Question: Provide a one-line summary of what is displayed.
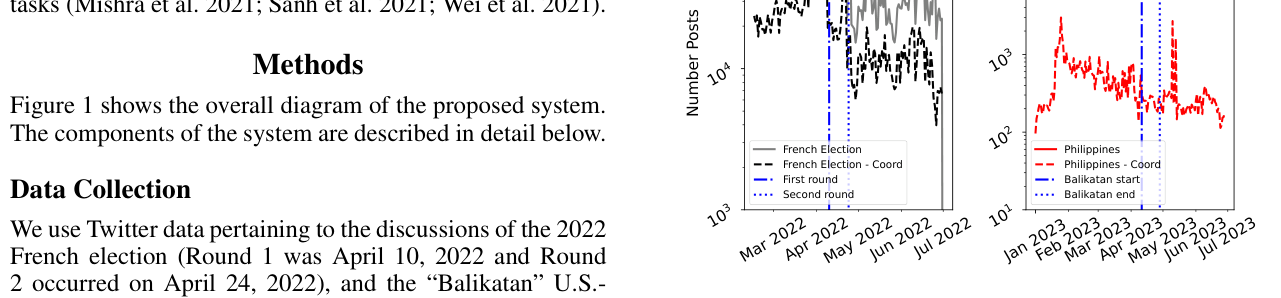
Answer: Number of posts over time from coordinated and non-coordinated accounts. (a) 2022 French election, with Round 1 and Round 2 elections labeled, and (b) 2023 Ba- likatan U.S.-Philippines military exercises that took place between April 11 and April 28, 2023.